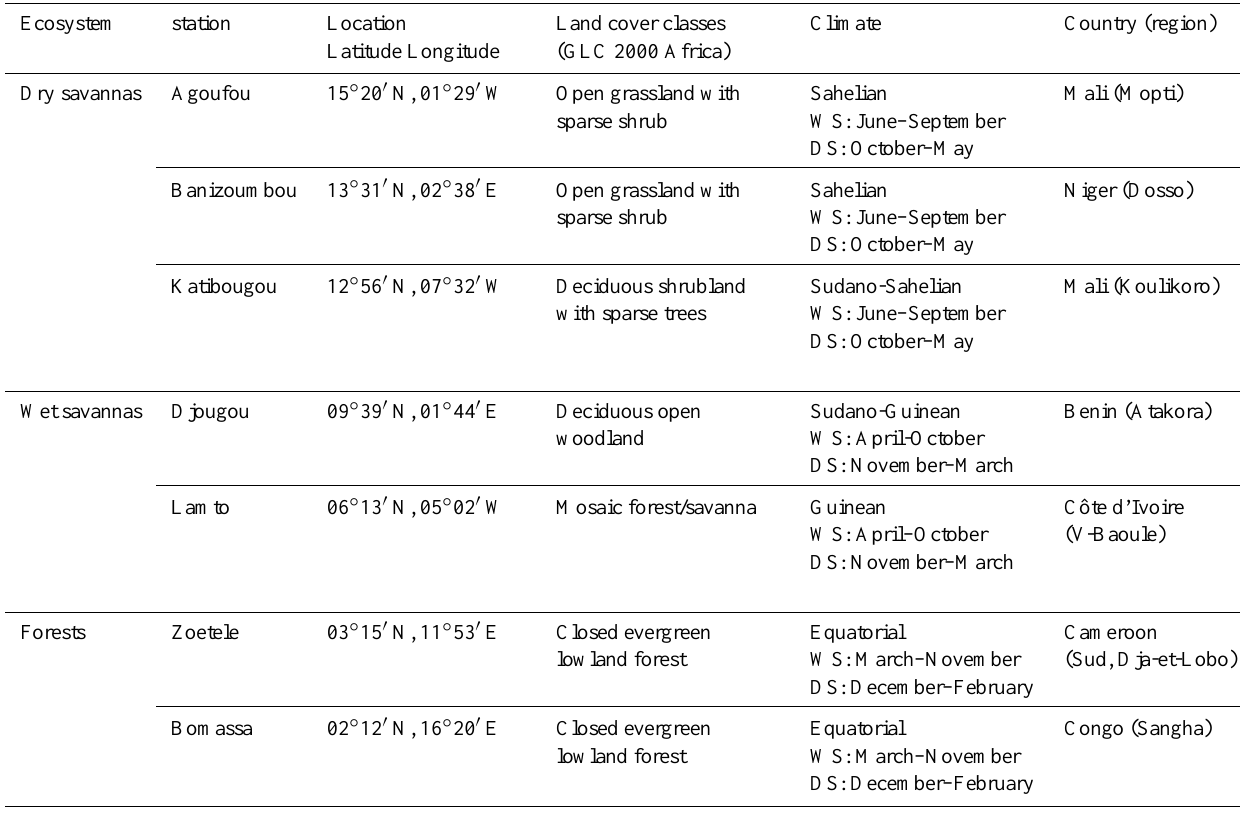
Table 1. Geographic, ecologic and climatic characteristics of the western and central Africa IDAF sites. WS: wet season; DS: dry season. Ecosystem